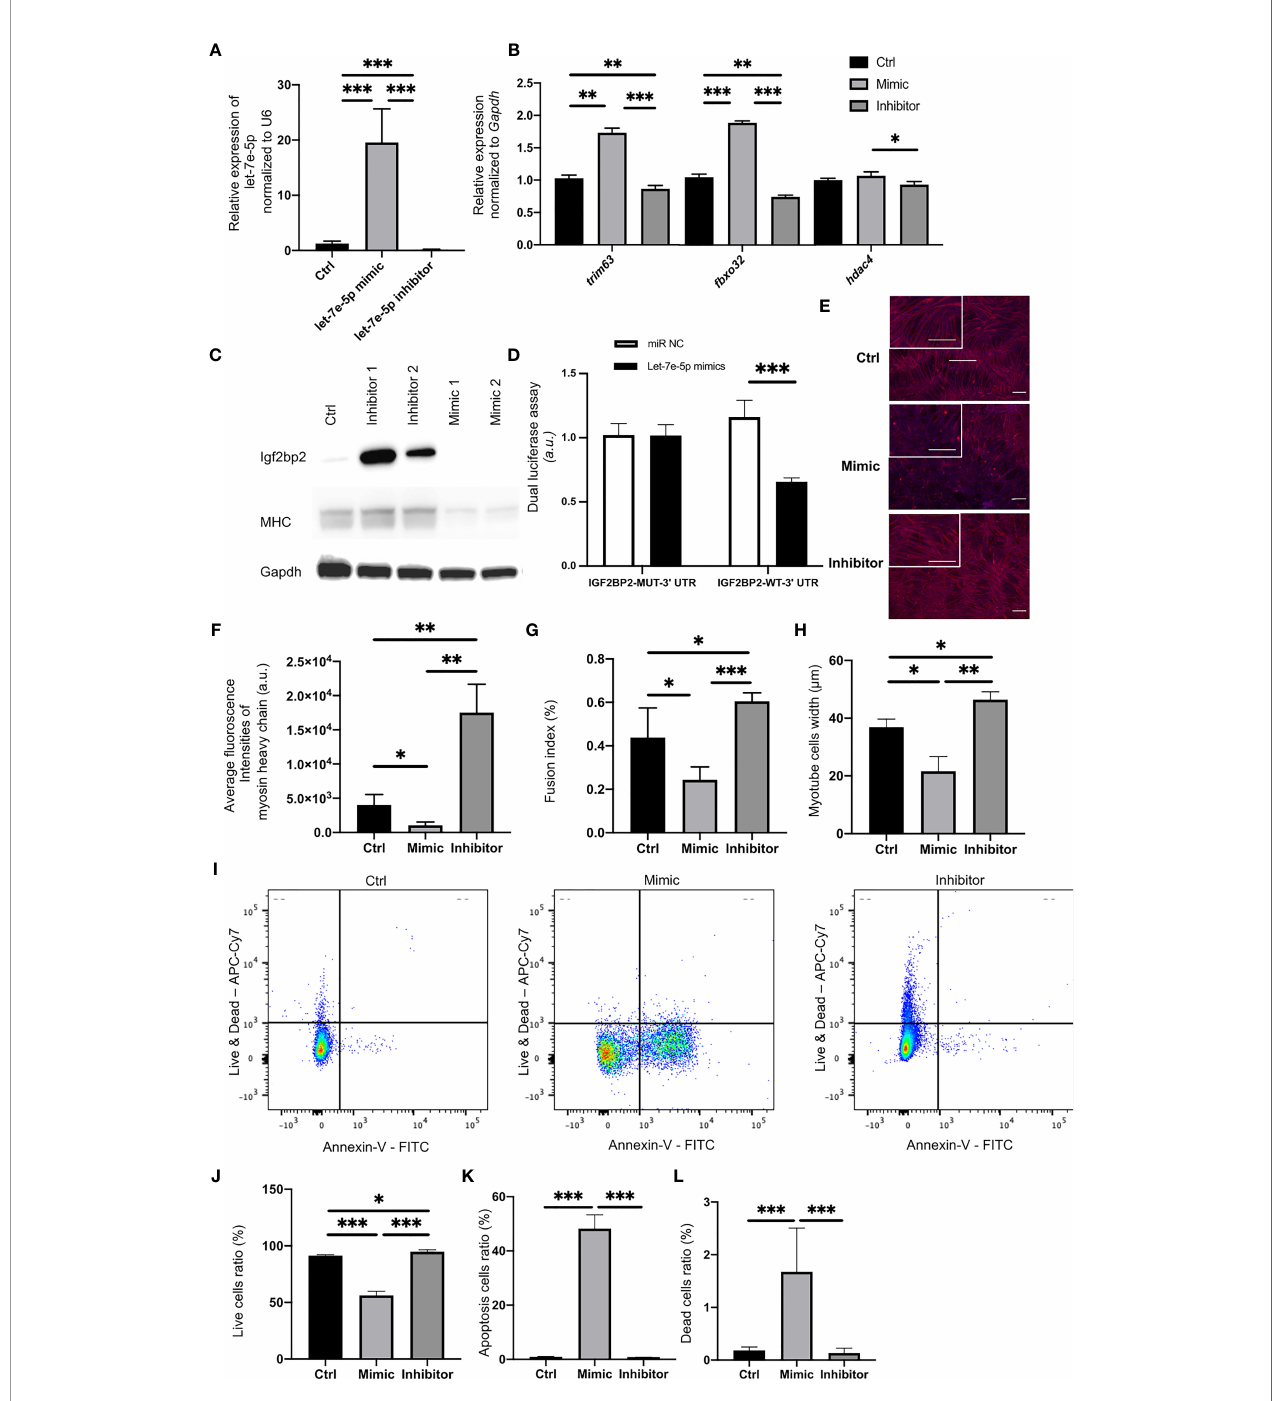
FIGURE 2 | Let-7e-5p inhibits myotube formation in C2C12 cells via repression of Igf2bp2. (A) Let-7e-5p expression in C2C12 cells was assessed after transfection with a let-7e-5p mimic/inhibitor (30 nM) (n = 6). (B) Relative expression of mRNAs of indicated genes in C2C12 cells normalized to Gapdh expression (n = 6). (C) Western blotting to detect the levels of Igf2bp2 and MHC and Gapdh in C2C12 myotube cells transfected with a let-7e-5p mimic/inhibitor (n=6). (D) Target validation study by luciferase assay (n=6). (E) Immunocytochemistry in C2C12 cells (n = 6). Red: Myosin heavy chain. Blue: DAPI. Scale bar, 50 µm. (F) Fluorescence intensity of myosin heavy chain (arbitrary units, a.u.) was compared (n = 6). (G) Fusion indices of C2C12 cells are shown (n = 6). (H) Width of myosin heavy chain are shown (n=6). (I) Representative fl ow cytometry plots of C2C12 cells Annexin V- PI- live cells, Annexin V+ PI- apoptosis cells, and Annexin V+ PI+ dead cells. (J) The ratio of live cells is shown (n=6). (K) The ratio of apoptosis cells is shown (n=6). (L) The ratio of dead cells is shown (n=6). Data represent the means±standard deviation (SD). *p = 0.05, **p = 0.01, ***p = 0.001 by one-way ANOVA. Kruskal-Wallis tests followed by Bonferroni correction of the Mann-Whitney U test were used for multiple comparisons. Ctrl: negative control, MHC: myosin heavy